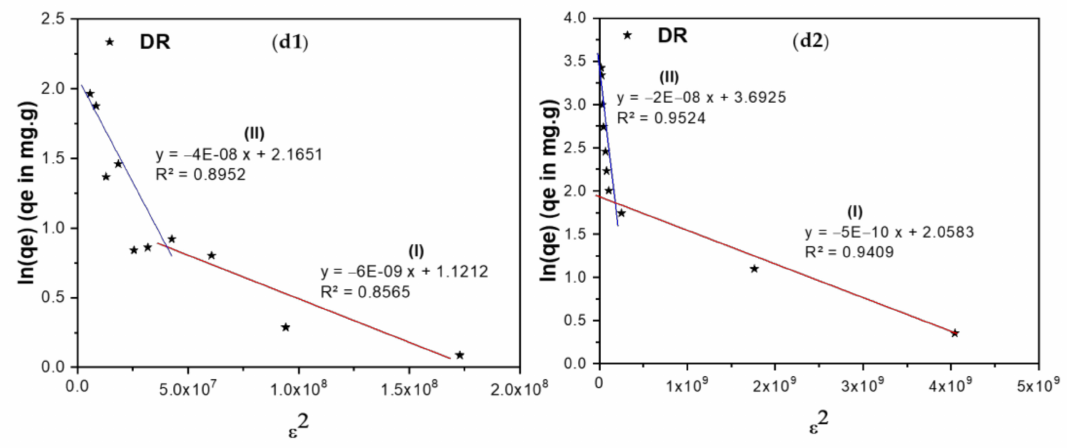
Figure 9. Adsorption isotherms of TIGC onto BCDP and MBC-DP, ( a1 , a2 ) Langmuir, ( b1 , b2 ) Freundlich, ( c1 , c2 ) Temkin, and ( d1 , d2 ) Dubinin–Radushkevich (DR) isotherms.